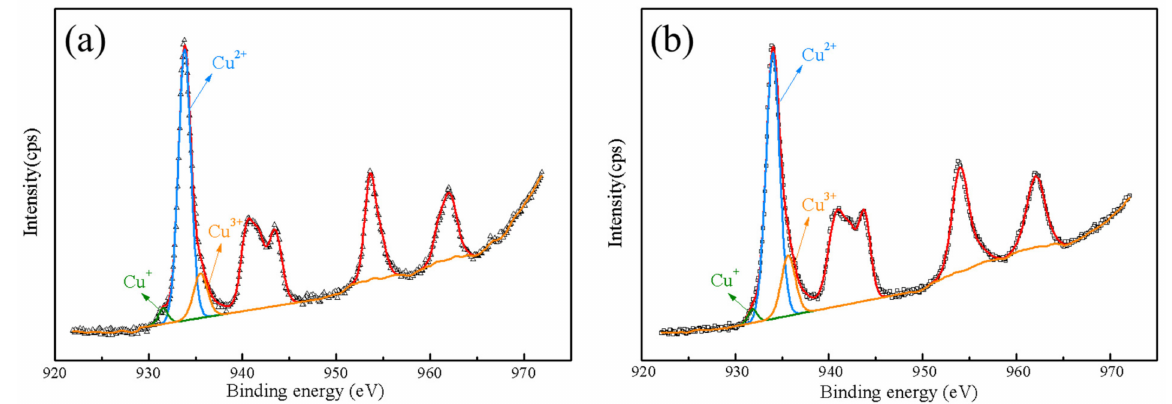
Figure 6. Cu 2 p 3/2 XPS spectra of ( a ) CCTO-800-3 h and ( b ) CCTO-1050-1 h